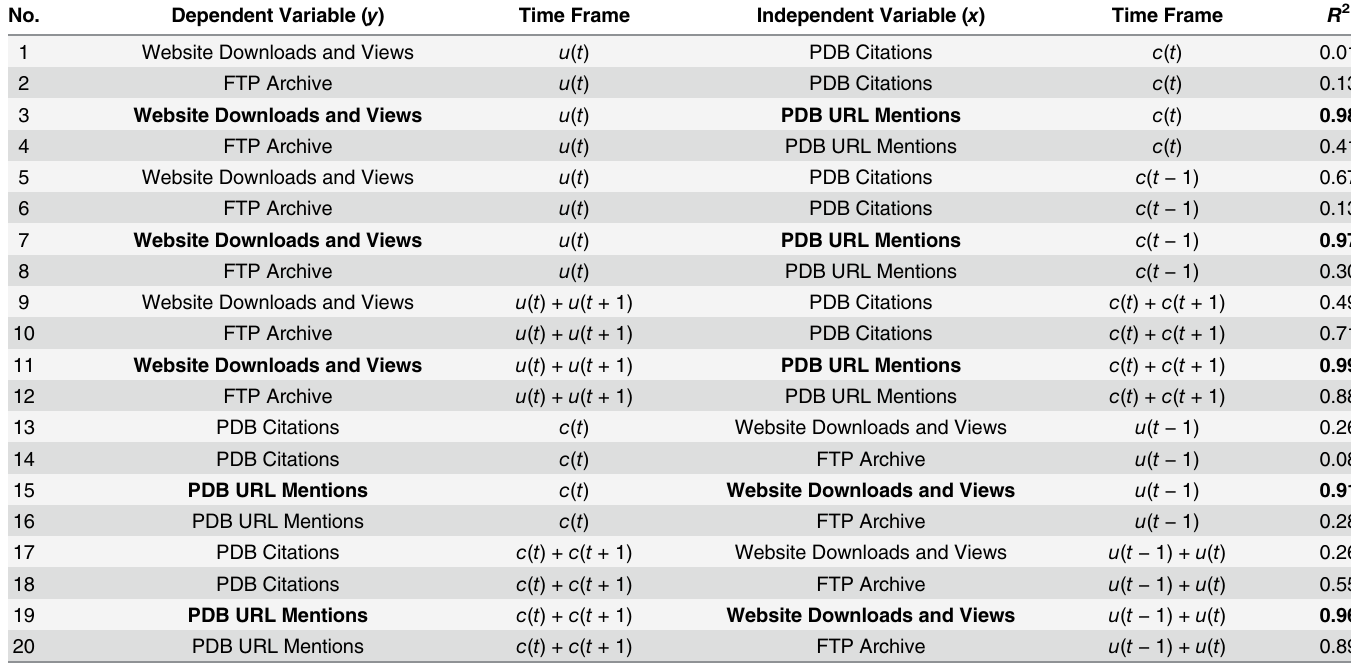
Table 4. The correlations between PDB data citations and PDB data usage statistics by linear modeling.